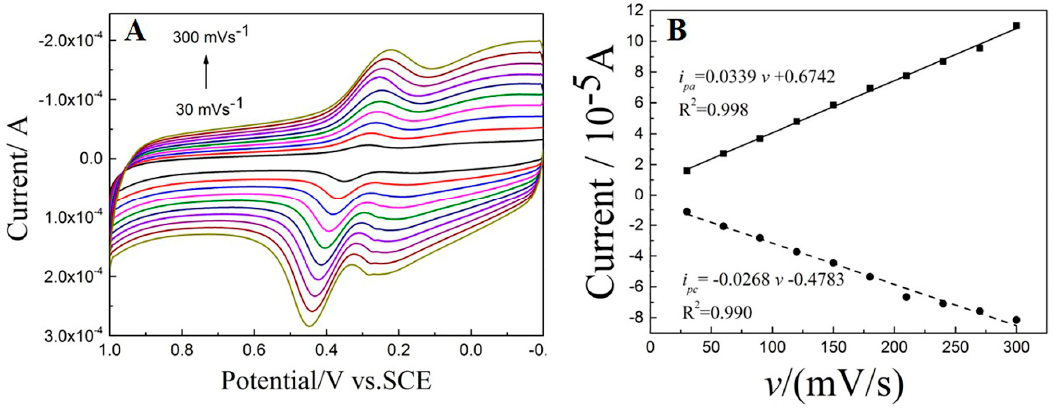
Figure 7. The effect of scan rate ( v ) on the peak current of 1 × 10 − 5 mol/L DA. ( A ) CVs of 1 × 10 − 5 mol/L DA on the Cu 2 O-RGO/GCE recorded in 0.1 M PBS with different scan rates ( v ); and ( B ) linear relationship between peak currents and scan rate ( v ).